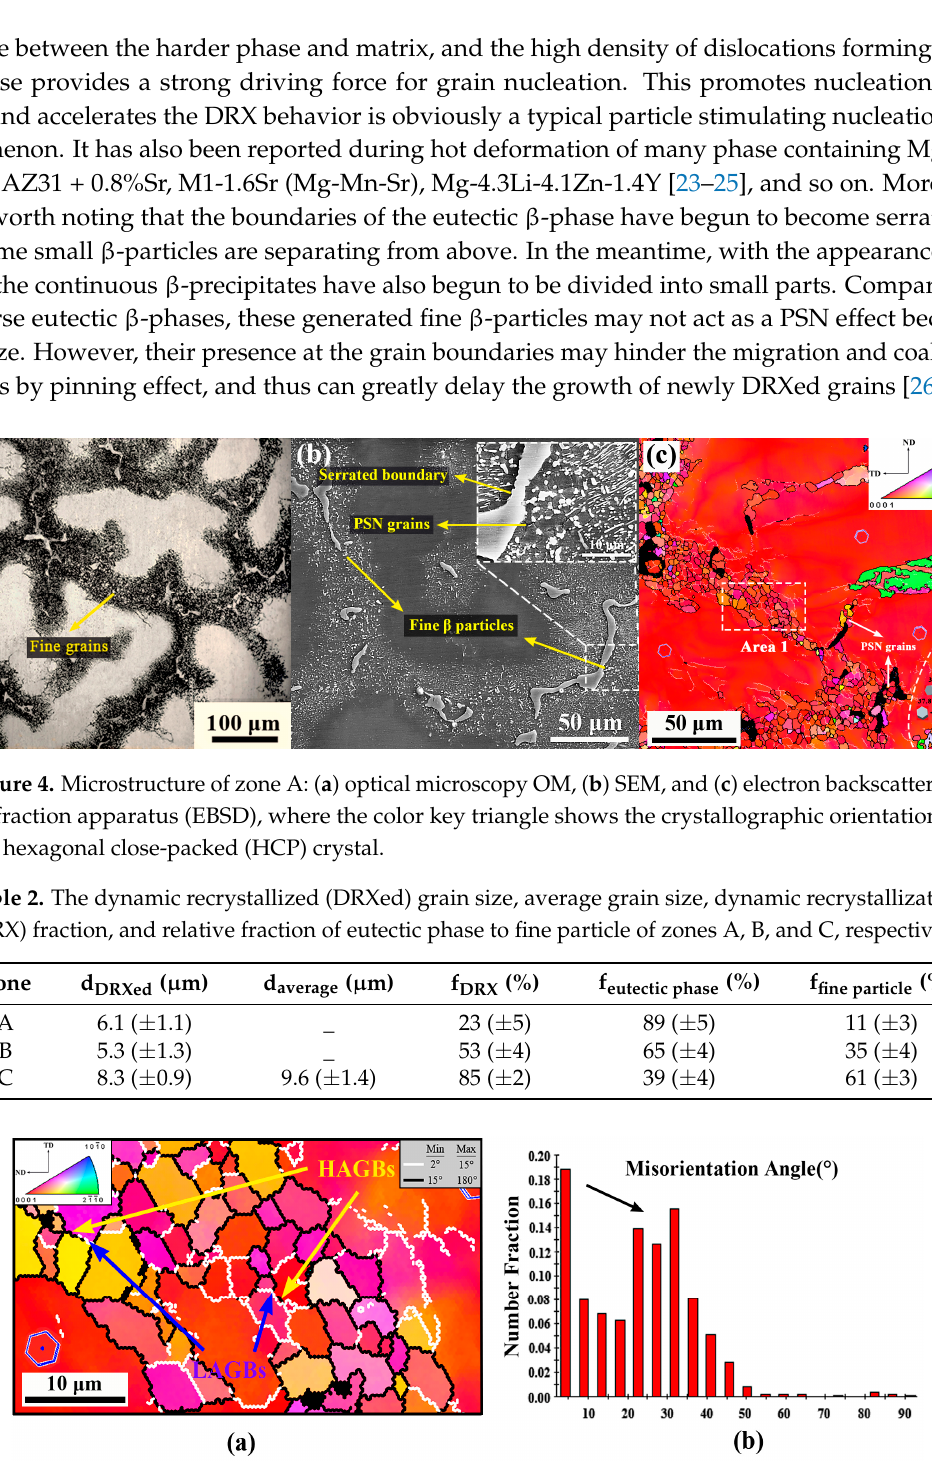
Figure 5. ( a ) Higher magnification of Area 1 indicated by white dashes in Figure 4c,and ( b ) corresponding misorientation angle distribution. The white and coarse black lines depict LAGBs (2°– 15°) and HAGBs (15°–180°), respectively.